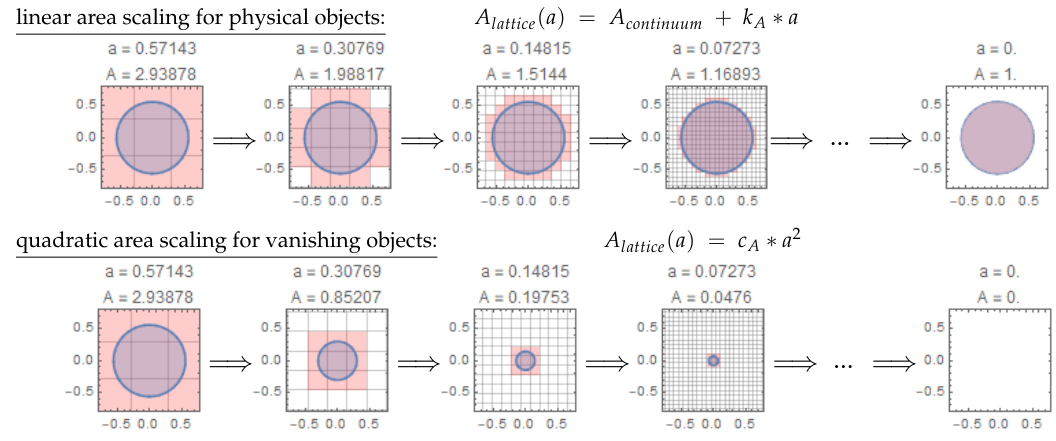
Figure 4. When measuring the area A continuum of a physical object piercing a plane in our toy lattice world, due to the pixel size a linear dependence on the lattice constant a is expected, as depicted in the upper part. Objects with cross sections proportional to plaquette areas lead to contributions of the order a 2 .